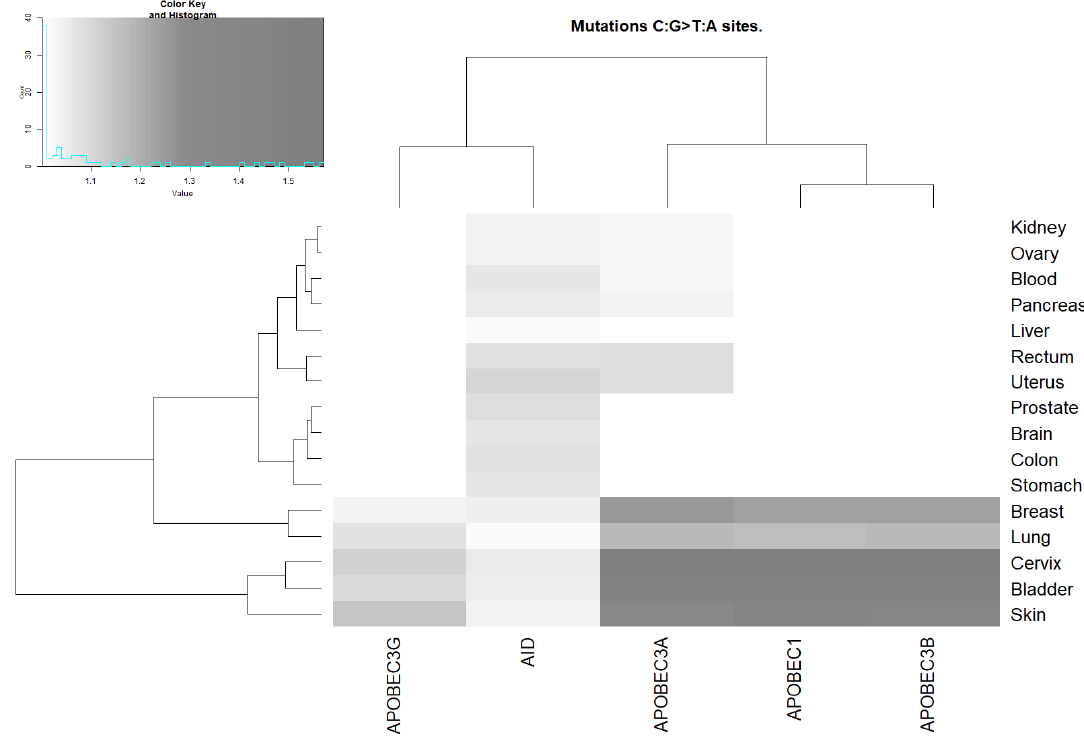
Figure 2. Correlation between AID/APOBEC mutable motifs and the sequence context of somatic C:G>T:A mutations. For the actual data, see Supplementary Table S6. The intensities of the gray color correspond to the ratio values (the ratio being the mean weight of the mutated sites divided by the mean weight of the non-mutated sites). The unweighted pair group method with arithmetic mean (UPGMA) clustering of ratio values for the AID/APOBEC footprints and tissues is shown as dendrograms. We attempted to estimate the fraction of somatic mutations associated with AID/APOBEC deamination using a mixture of two normal distributions (see Sections 3 and 4 for details). For example, estimated fractions of APOBEC1-associated mutations (0.66, 0.48, 0.74, 0.39, and 0.62) look consistent with the smallest value of 0.39 corresponding to the lowest ratio value (1.064, APOBEC1, lung), although this method sometimes yielded potentially underestimated values (0.17, APOBEC3G, cervix, ratio = 1.113) and overestimated values (0.92, APOBEC3G, bladder, ratio = 1.101) (Supplementary